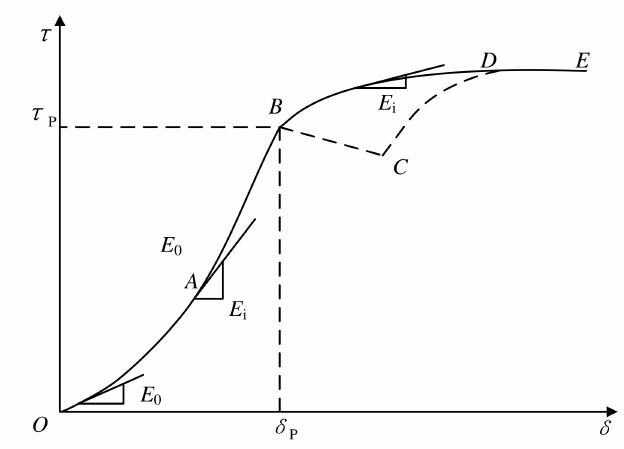
Figure 3. S-type Falling τ - δ